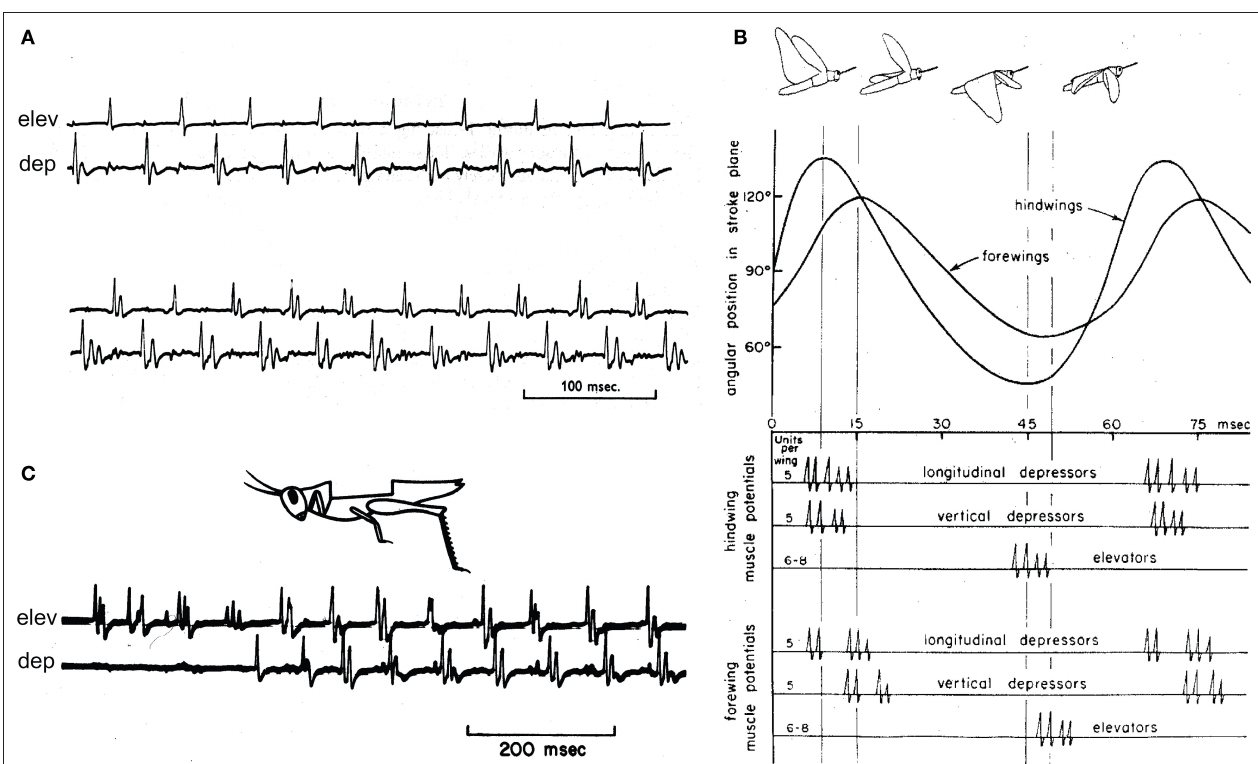
Figure 2 | Motor patterns that drive flight in locusts and other neurogenic insects. (A) Two sections of typical flight motor output recorded as muscle action potentials in a flying locust, from Waldron (1967). Electrodes in a wing elevator (elev) muscle and a wing depressor (dep) muscle recorded alternating spikes from these antagonistic muscles. Since transmission from the motor neurons to each muscle is one-for-one (Wilson and Weis-Fogh, 1962), these recordings report each spike in the motor neurons that innervate each muscle. These two sections of a continuous recording were separated by several seconds during which the locust increased its power-output by increasing its wing-beat frequency and increasing the numbers of spikes each neuron fired in a cycle from one to